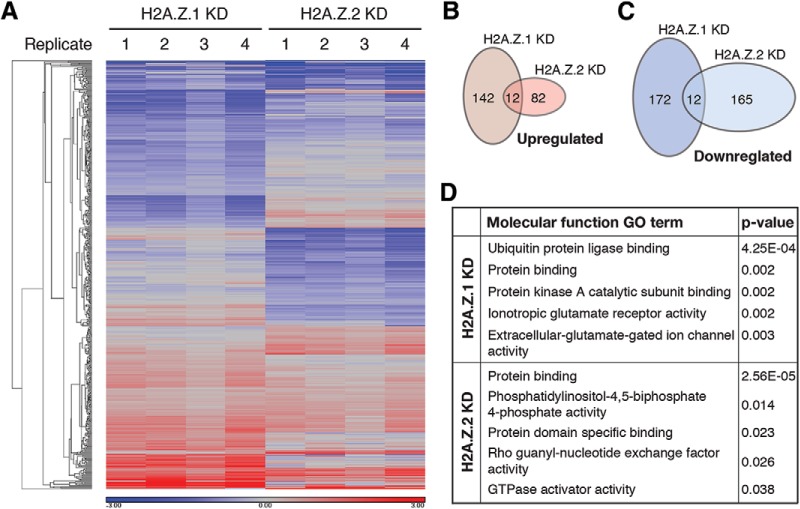
H2A.Z hypervariant depletion alters baseline expression of mostly nonidentical gene cohorts. A, Heat map showing changes in gene expression as detected by microarray analysis after depletion of H2A.Z.1 and H2A.Z.2 compared to control neurons. N = 4. Genes showing >1.25-fold change with p < 0.001 are shown here. B, C, Venn diagrams depicting total number of genes that are either upregulated (B) or downregulated (C) after depletion of H2A.Z.1 or H2A.Z.2. Note the nonoverlapping nature of such gene sets. D, Top five GO terms derived from molecular function gene ontology analysis (DAVID) for H2A.Z.1 and H2A.Z.2 target genes.